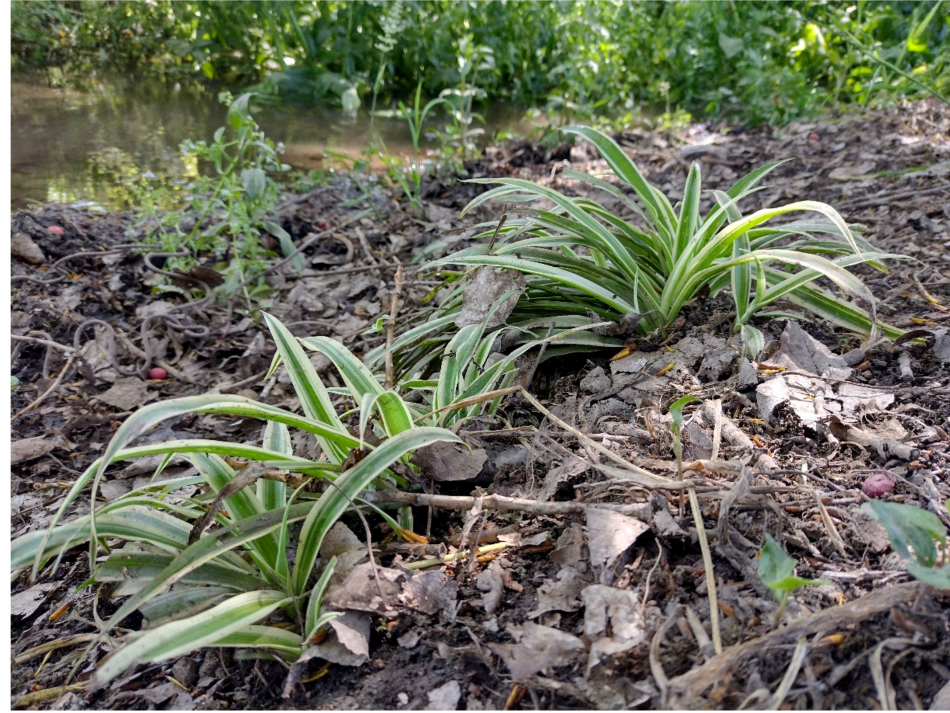
Figure 59. Chlorophytum comosum along channel Acqua Mariana (Acquedotti